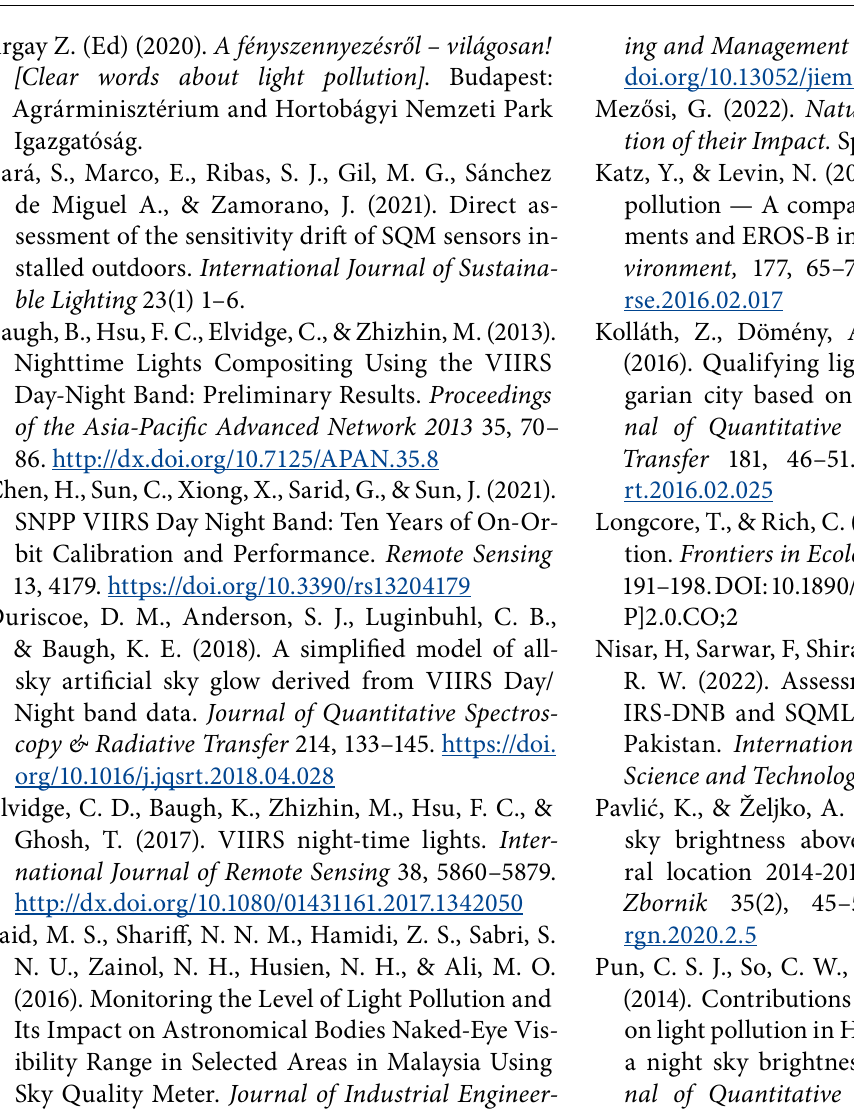
Figure 6.C. Neighbourhoods with the lowest (blue) and highest change in astronomical light pollution between 2011/12 and